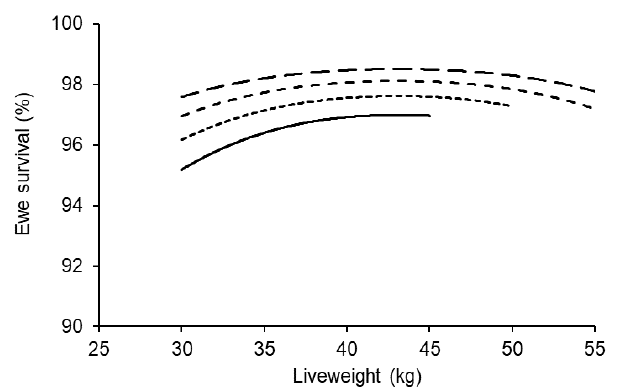
Figure 5. The effect of liveweight at the start of breeding on survival of ewe lambs that were 6 (bottom), 7, 8 or 9 (top) months of age. The data represent over 8800 maternal composite ewe lambs that were pregnant and the average across the ewe lambs ’ own birth type and her pregnancy status.